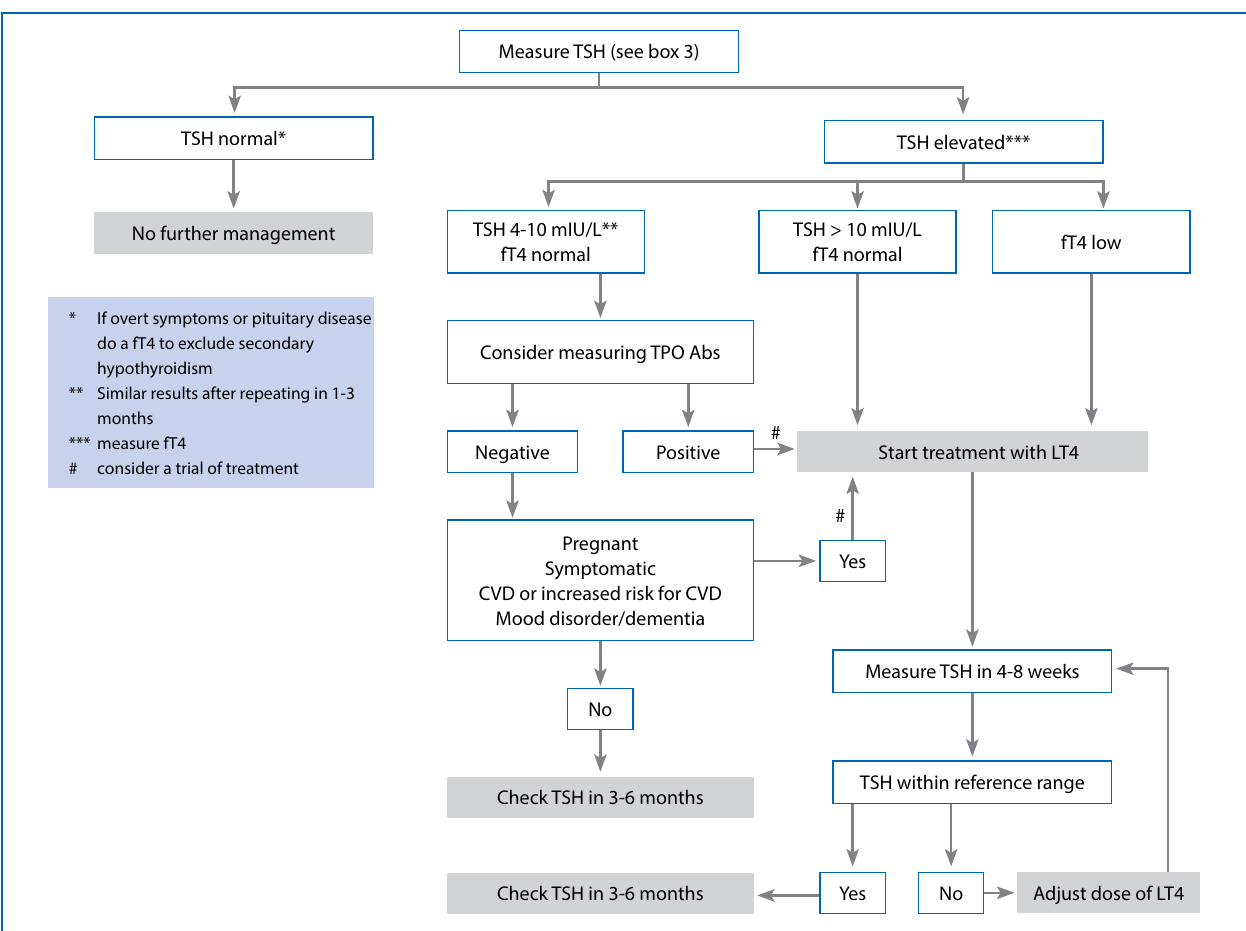
Figure 1: Algorithm for the management of a patient with